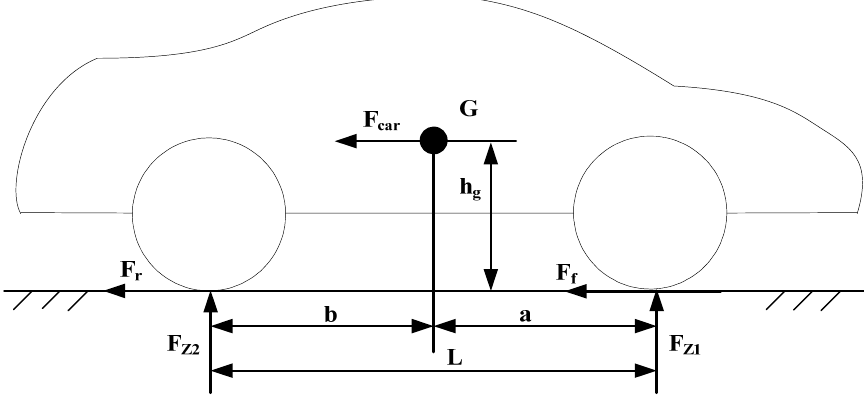
Figure 3. Load movement which occurs when brake operations are performed while running on flat